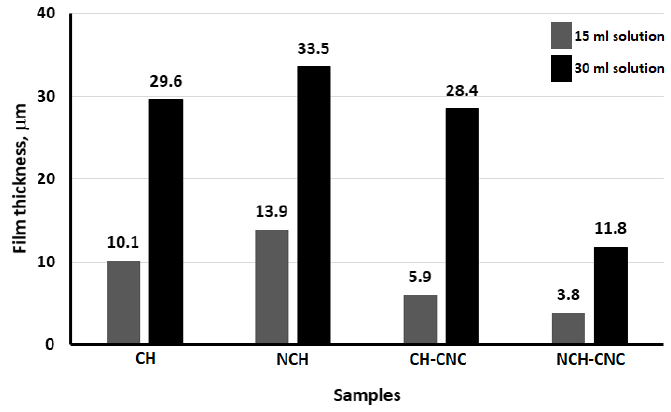
Figure 7. Film thickness measurement.